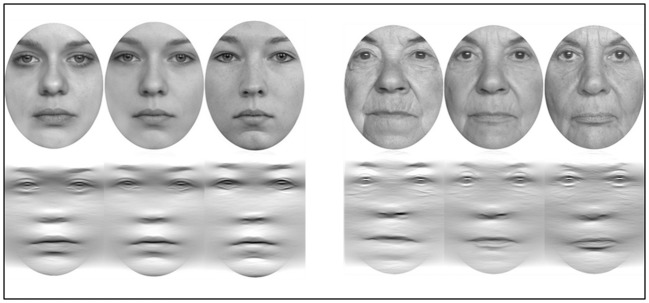
Overview of experimental stimuli. (Upper row) young faces (on the left) and older faces are displayed containing 0, 50, and 100% target-information. (Lower row) filtered young faces and filtered older faces. Face stimuli were obtained from Lindenberger et al. (2007) and Langner et al. (2010).